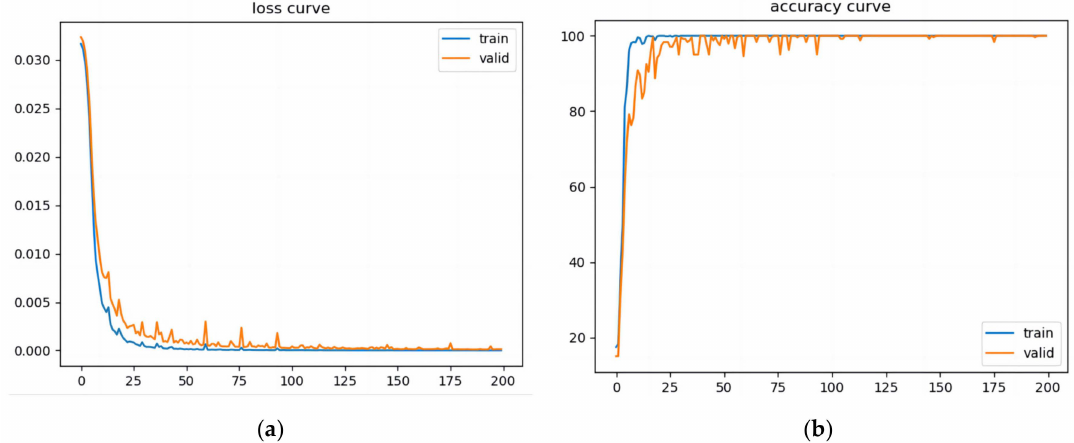
Figure 11. TC-CNN ‘s overall training of 200 epochs. ( a ) Loss function curve; ( b ) Accuracy curve.